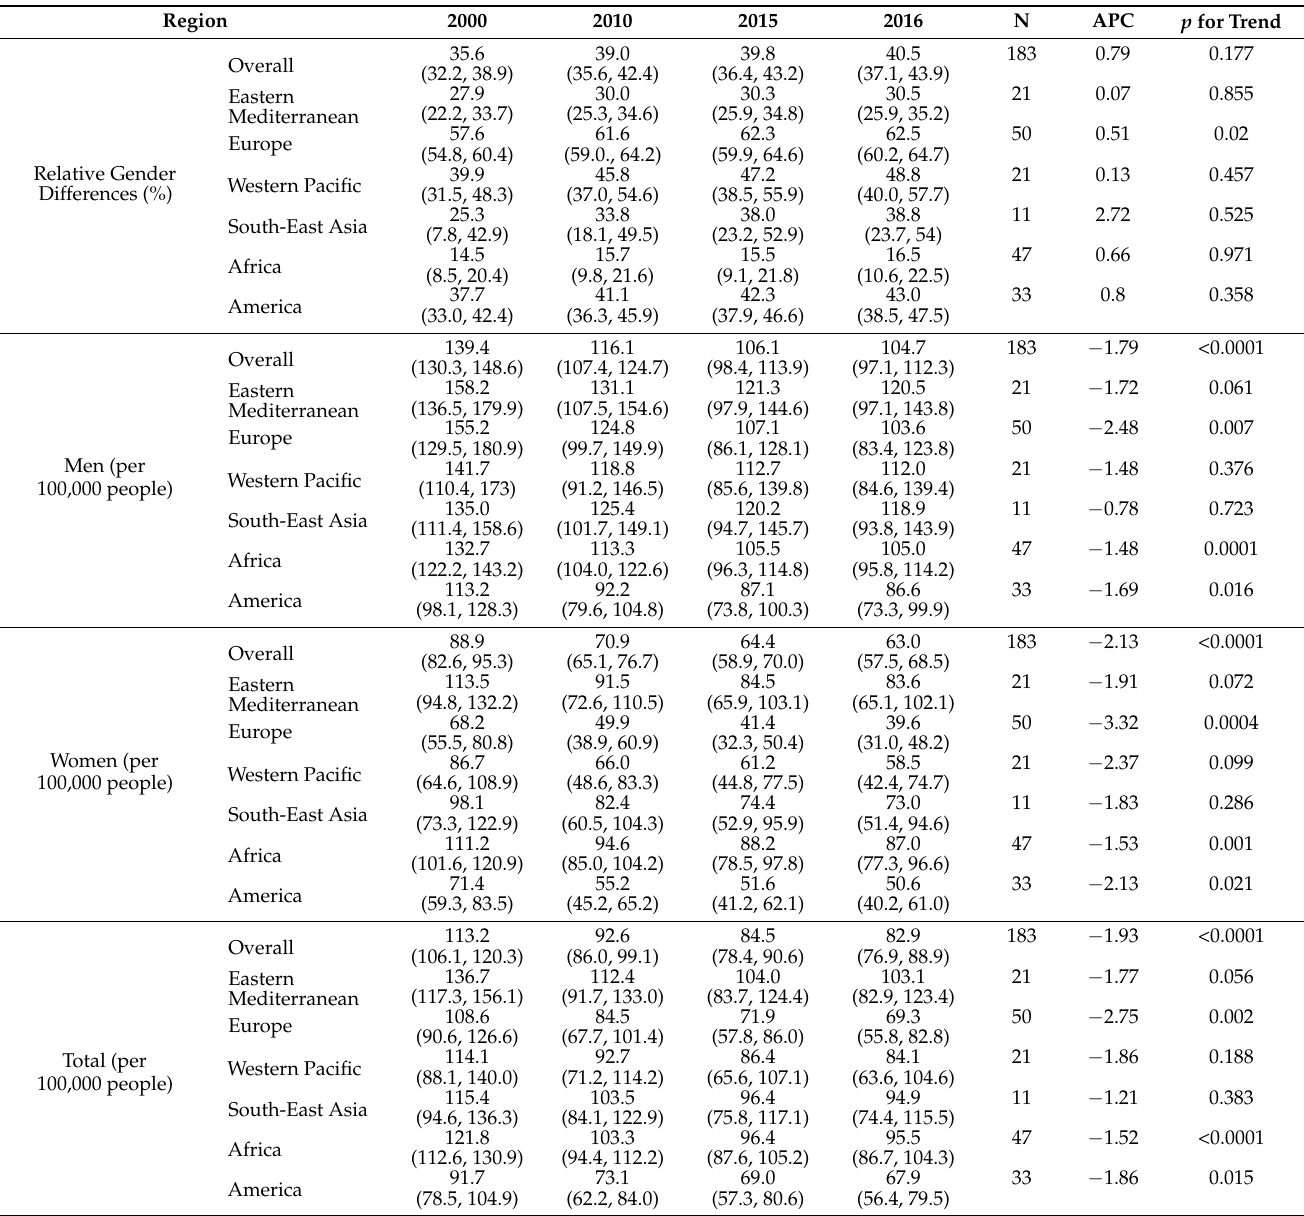
Table 1. Age-standardized premature CVD-related death rates and relative gender differences across geographic regions, from 2000 to